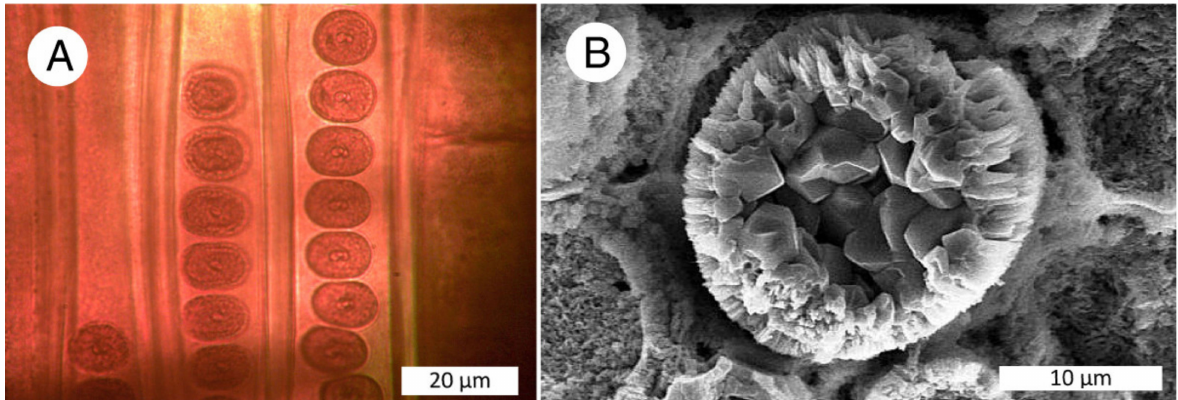
Figure 10. Chalcedony and quartz in fossil wood. ( A ) Chinle Formation Triassic wood, radial view showing intertracheid pits. The darker color of the silica replacing the pits is presumably due to trace element differences between the pits and adjacent cell wall. ( B ) Miocene angiosperm wood from Yakima Firing Center, central Washington, USA. A key preservation feature was that the open vessels allowed space for euhedral quartz crystals to form after the adjacent tissue had already been silicified.